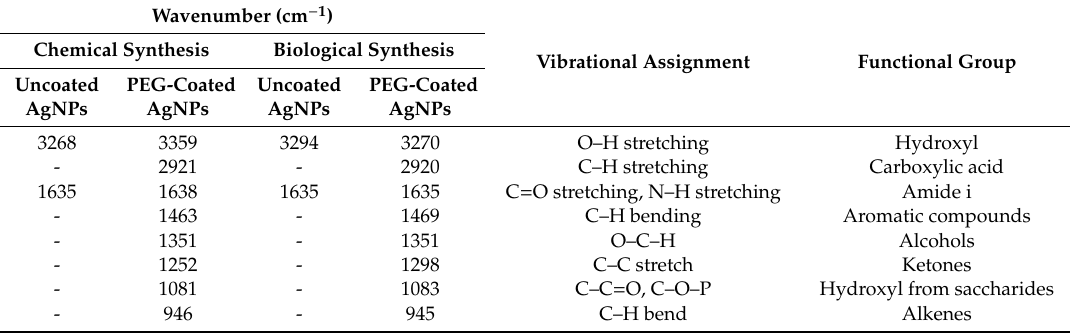
Table 1. Main absorption peaks and vibrational assignments with functional groups interpretation of the uncoated and PEG-coated AgNPs produced from chemical and biological synthesis [9,15,26,27].